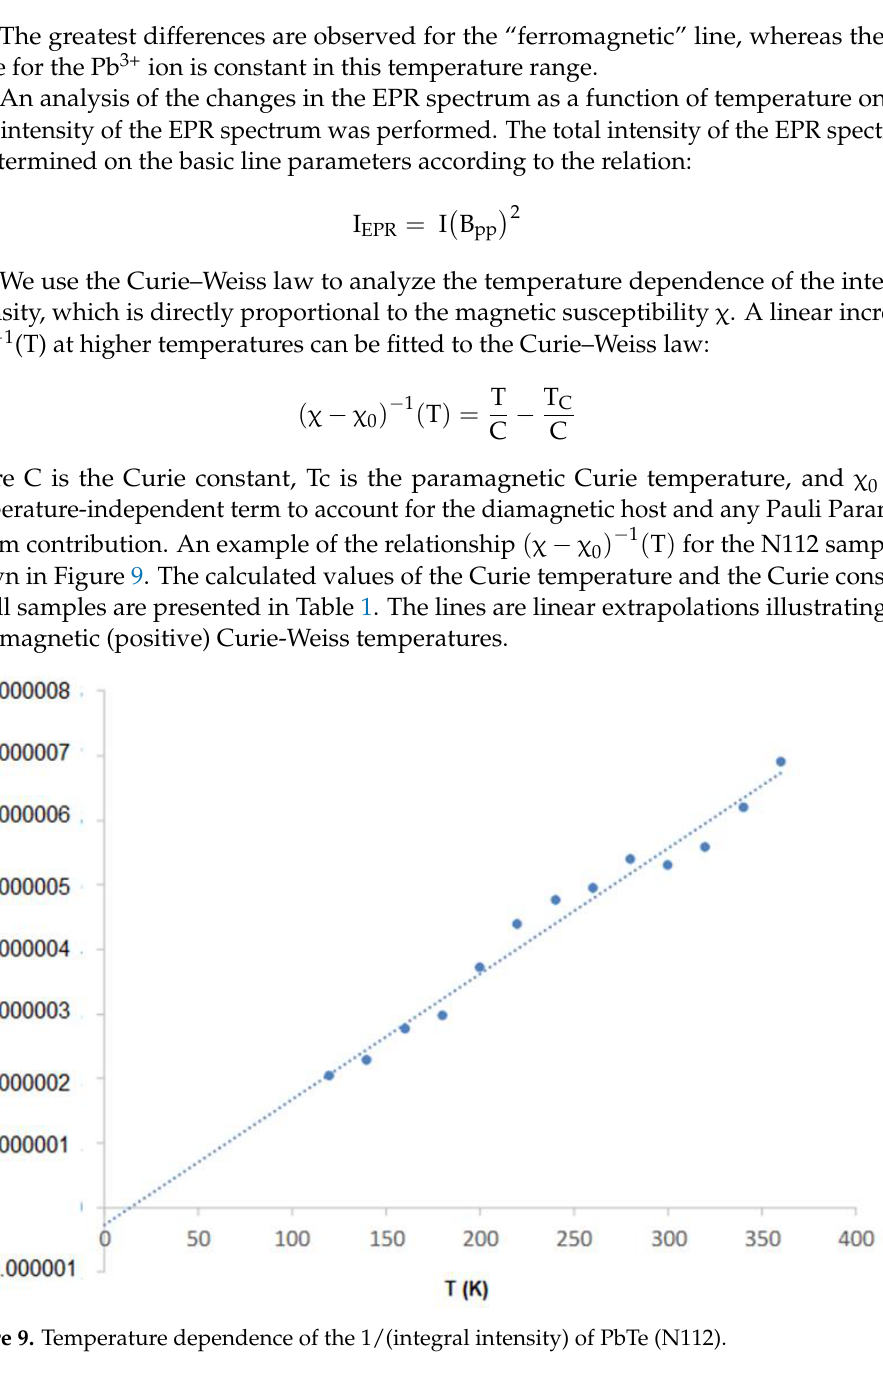
Figure 9. Temperature dependence of the 1/(integral intensity) of PbTe (N112).